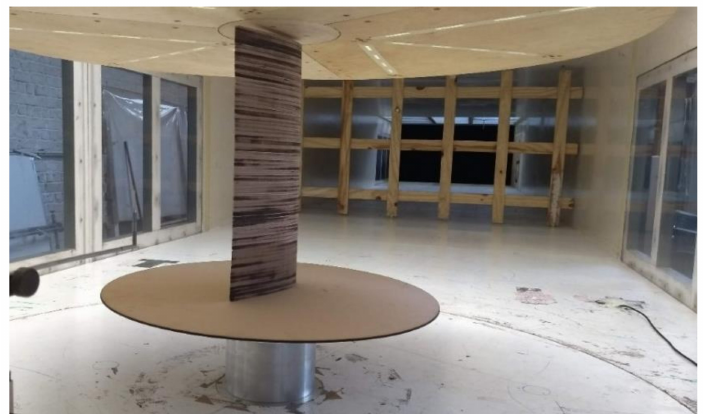
Figure 5. Airfoil model mounted inside the FLOW wind tunnel, with the turbulence grid installed in the background.